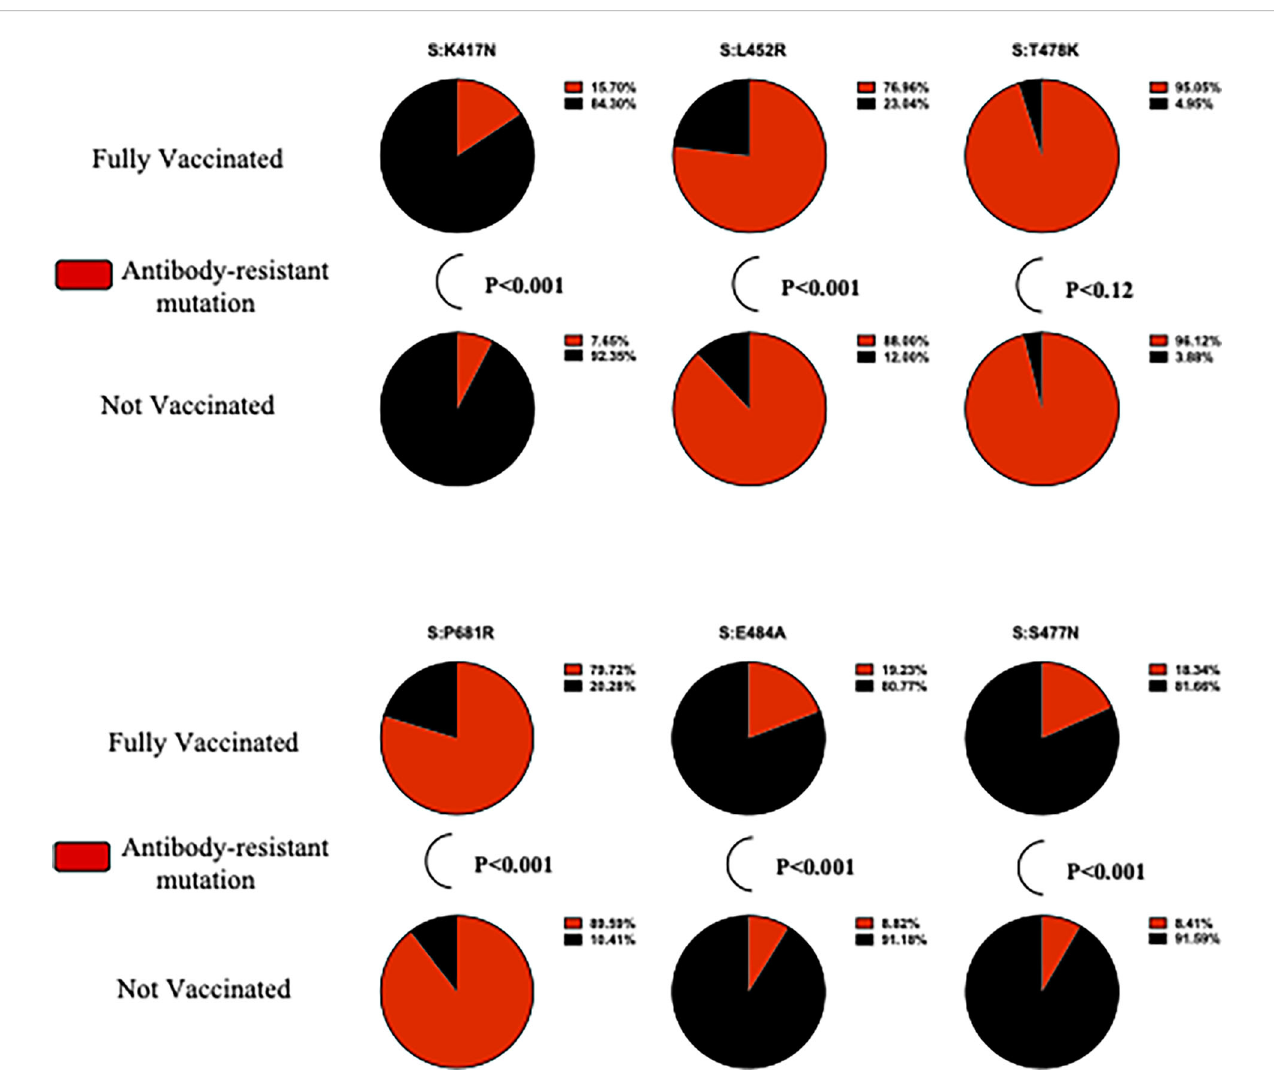
FIGURE 2 The proportion of SARS-CoV-2 genomes containing antibody-resistant